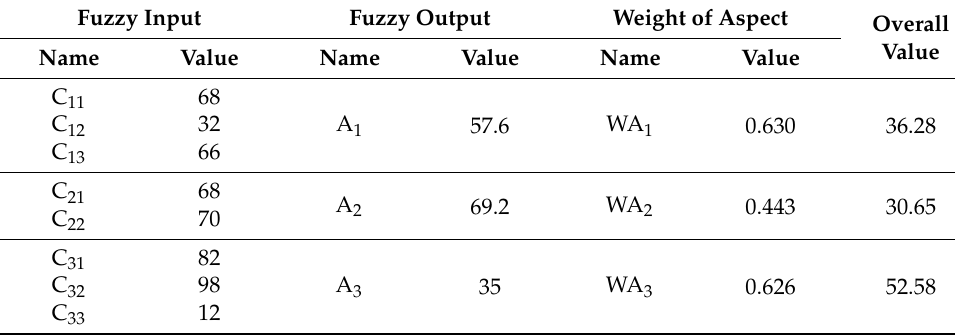
Table 11. Final scores of the AMT implementation prediction model .